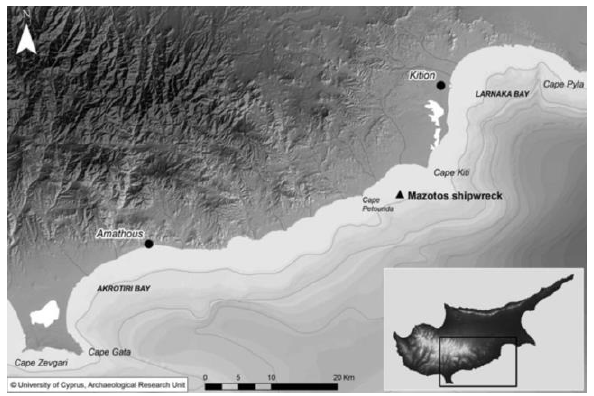
Figure 1. Location of Mazotos (Demesticha, 2011)